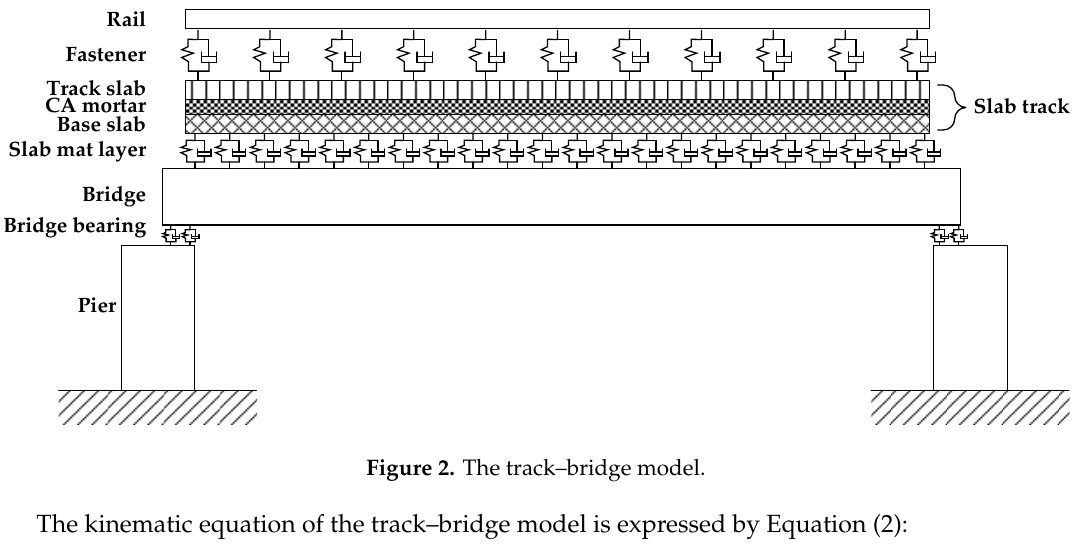
Figure 2. The track – bridge model. Figure 2. The track–bridge